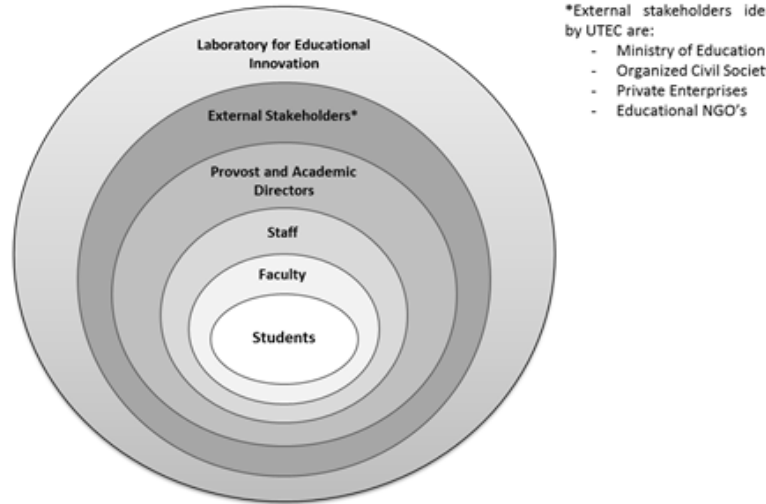
Fig. 1. Stakeholders’ map showing the different players that are being brought together by